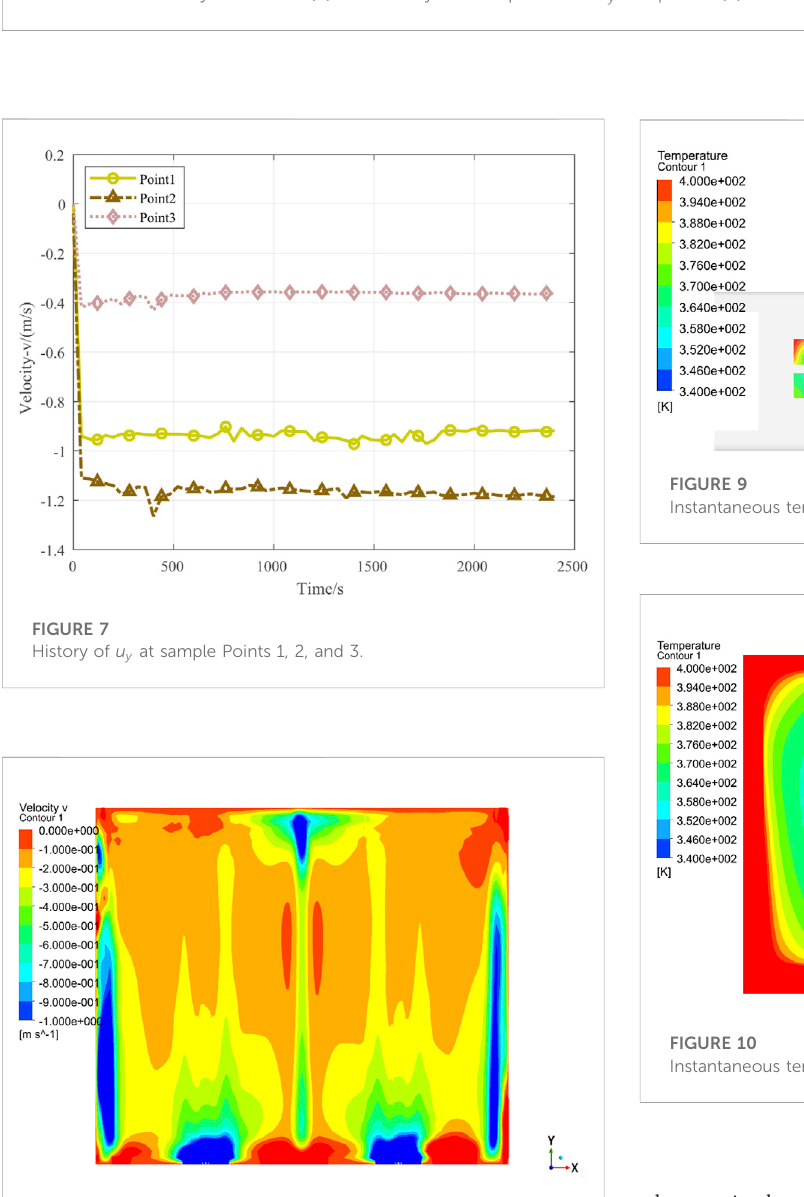
FIGURE 8 Instantaneous contour plot of u y for Plane 2 at 2,400 s.